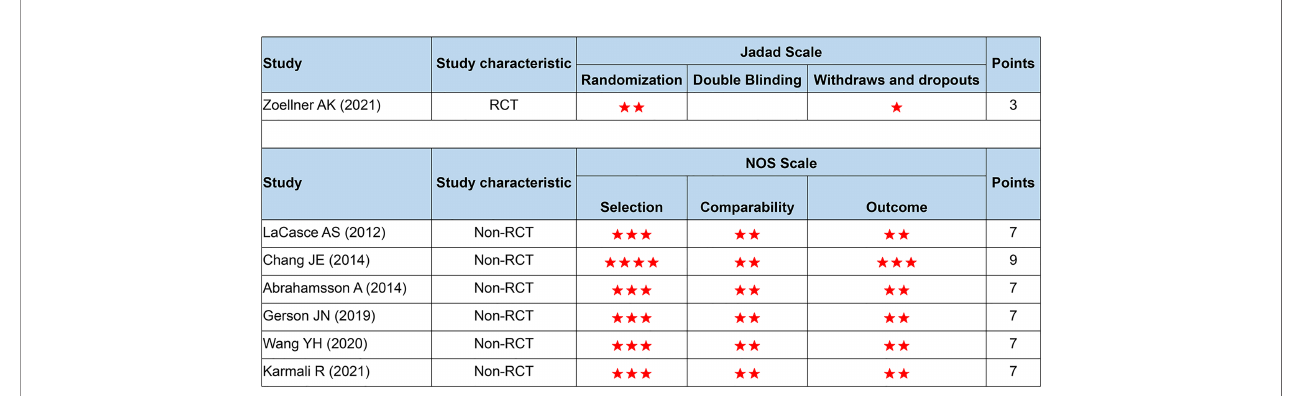
FIGURE 2 | Quality assessment based on the Jadad and NOS scale. NOS, the Newcastle-Ottawa Scale; RCT, randomized controlled trials. Number of asterisks denotes scores.